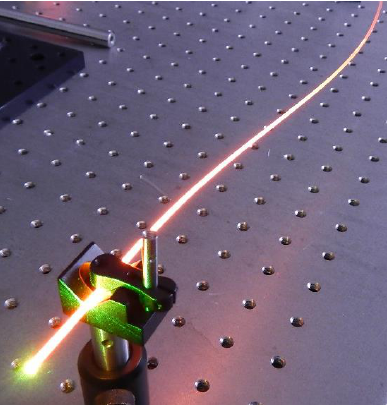
Figure 2. The photo of Oxazine 170 perchlorate doped PMMA fiber under 532 nm